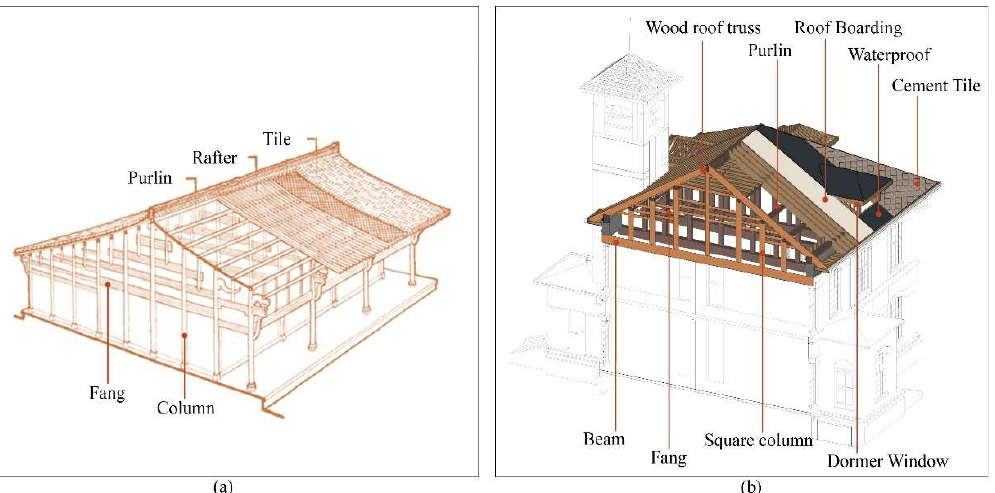
Figure 11. Comparison of the Chinese traditional roof-truss system and bell tower roof-truss system (source: author). ( a ) Chinese traditional roof-truss system “cross type wood structure” ( b ) Bell tower roof-truss system.